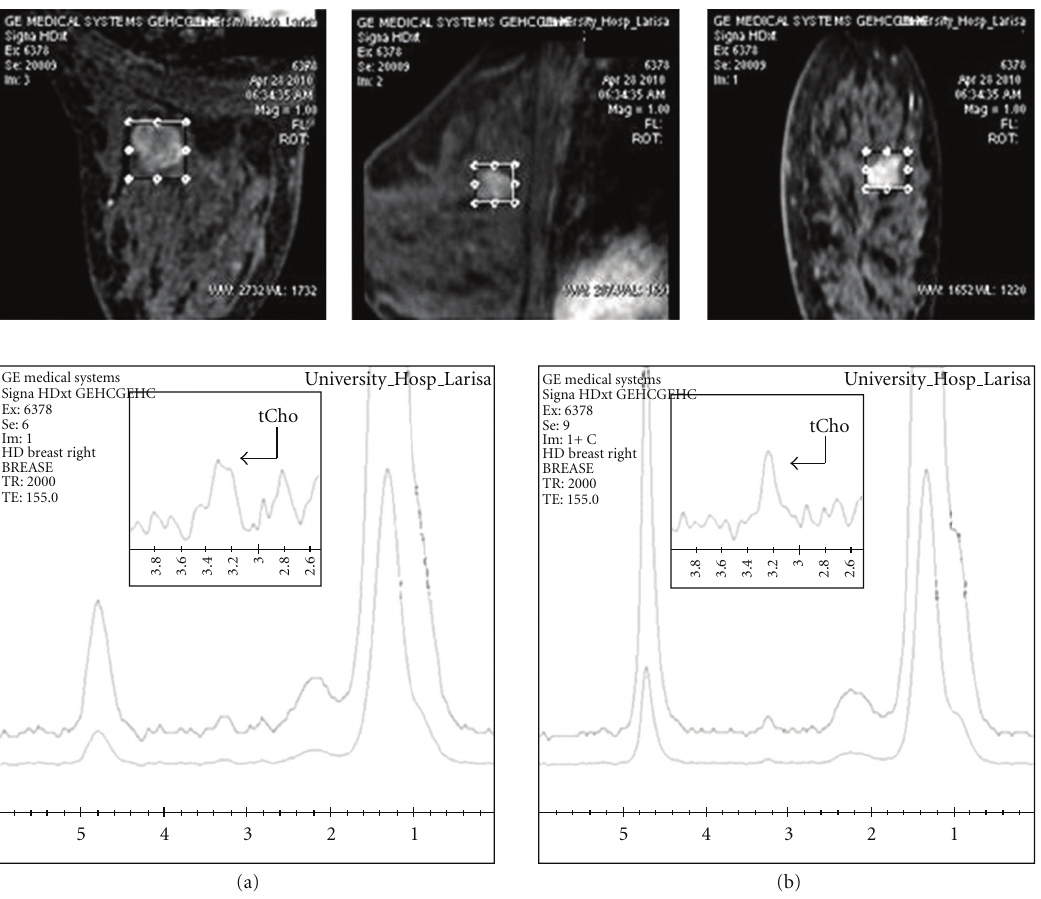
Figure 3: Breast MR spectra of a 35-year old patient with malignant breast lesion, before contrast injection (a) using a voxel of 15 ∗ 15 ∗ 15 cm 3 and 8min after (b) contrast injection using a voxel of 17 ∗ 16.3 ∗ 15 cm 3 which is more adapted to the lesion’s size. After contrast injection, tCho peak is clearly